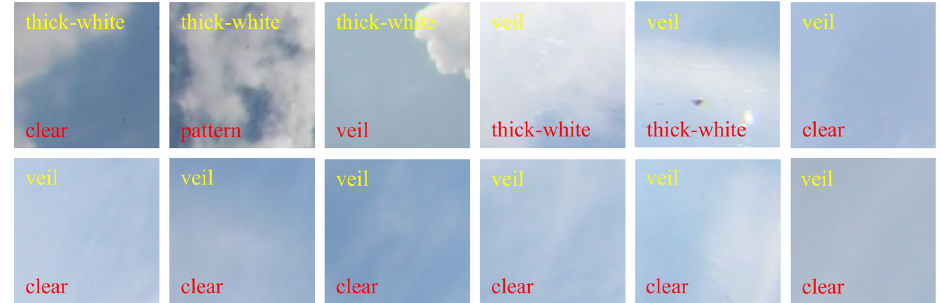
Figure 8. Misclassified images of the SWIMCAT dataset. The yellow labels are the ground truth, and red labels are predicted cloud types. The veil clouds are prone to be misclassified as clear sky, since the veil clouds are thin and have high light transmittance; some veil clouds are misclassified as thick white cloud, when the camera lens is contaminated and the clouds are too thick. Besides, a small amount of thick white cloud is misclassified as clear sky, pattern clouds or veil clouds.